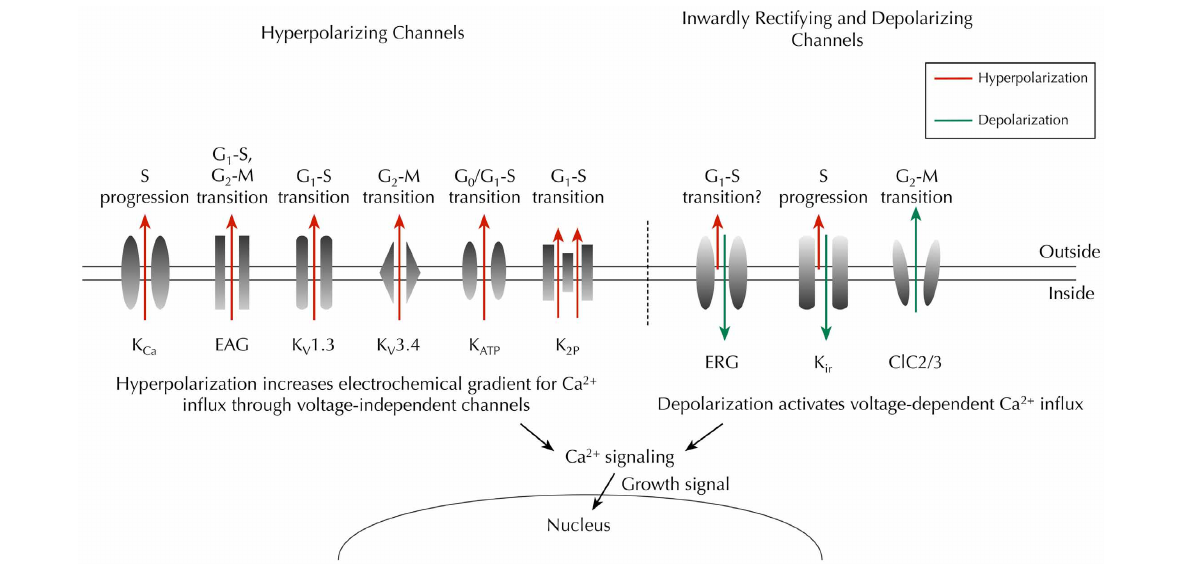
FIGURE 3 | Key ion channels that regulate V m and cell cycle progression in cancer. Hyperpolarizing channels (outward I K , red) would increase the driving force for Ca 2 + influx through voltage-independent channels, whereas inwardly rectifying K + channels (predominantly inward I K , green) and chloride channels (outward Cl − , green) would depolarize the V m , thus enabling activation of voltage-dependent Ca 2 + influx (Schwab et al., 2012). Time- and